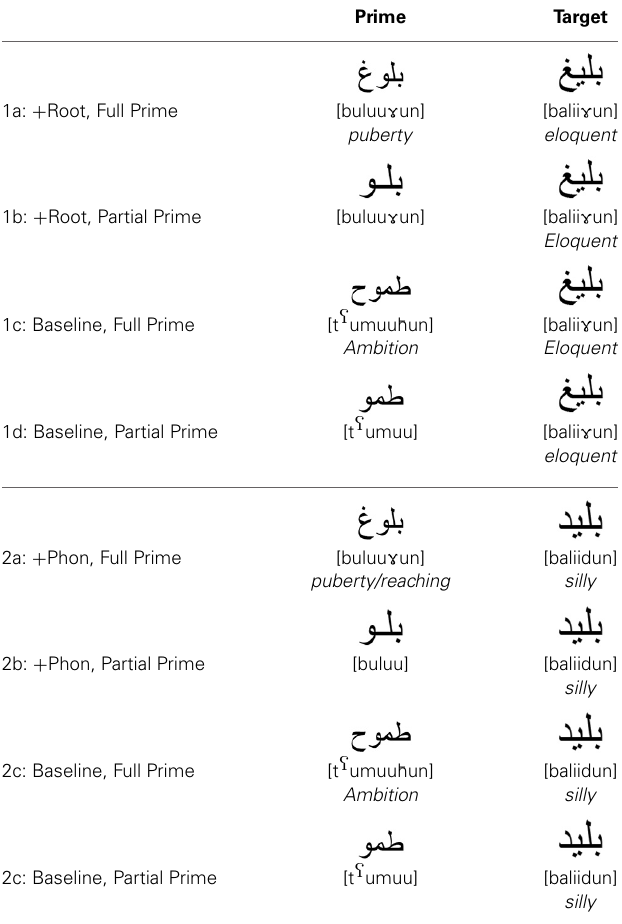
Table 1 | Examples of stimuli used in the different conditions of experiment